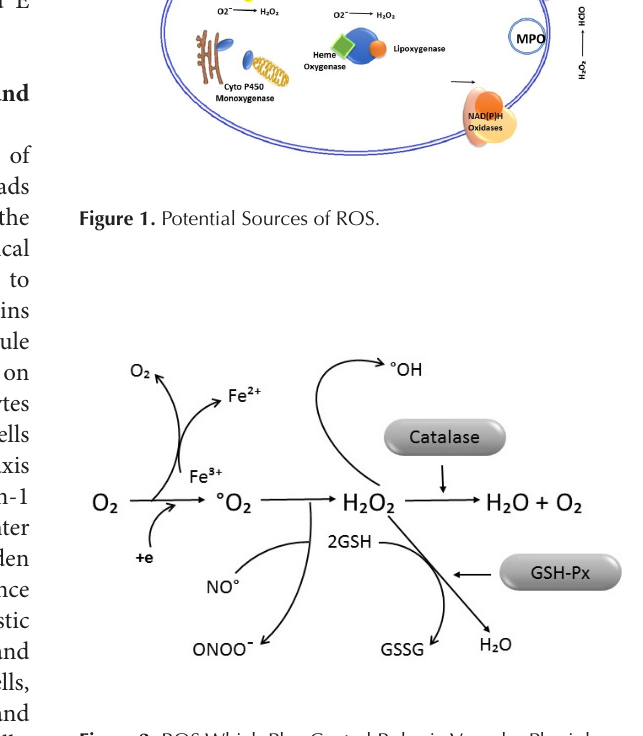
Figure 2 . ROS Which Play Central Roles in Vascular